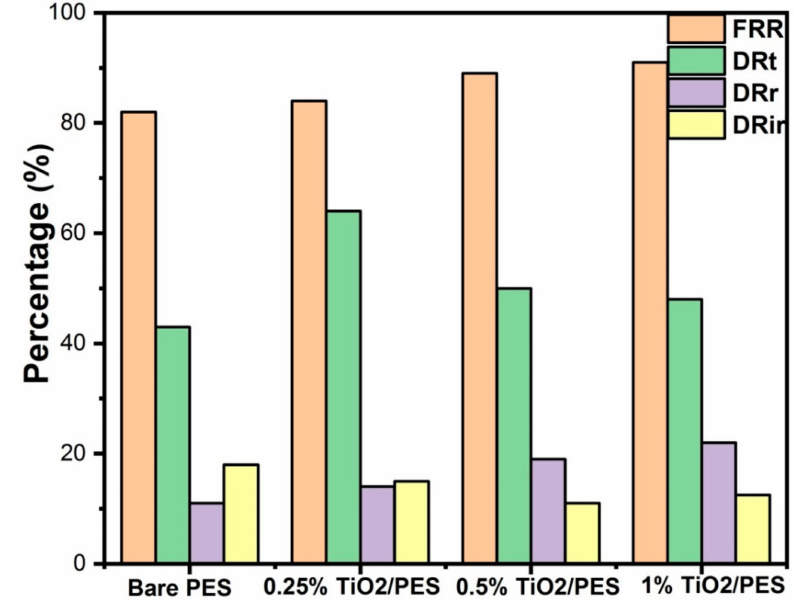
Figure 11. Comparisons of fouling characteristics of unmodified PES and PES / discrete TiO 2 nanocomposite